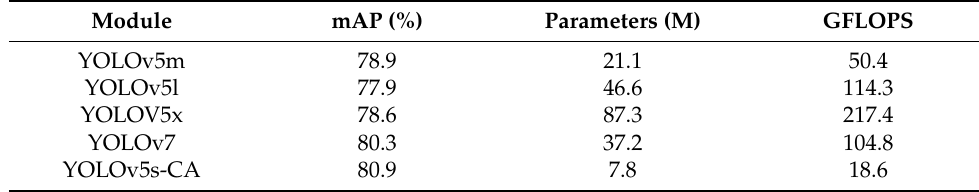
Table 3. Results of comparative